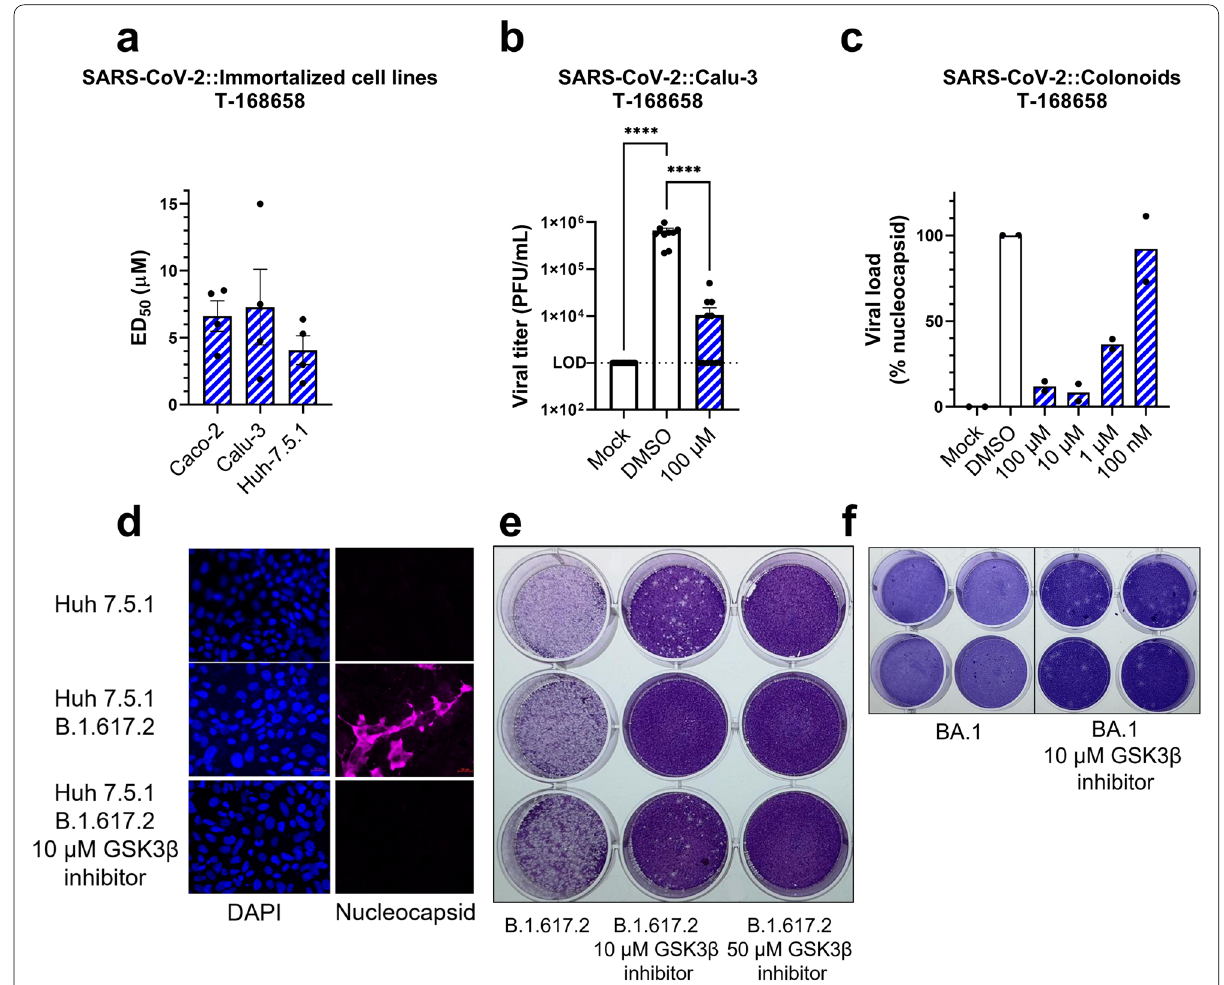
Fig. 3 Characterization of T‑168658 inhibitory activity. a Dose‑response inhibition effect of T‑1686568 in three infected, immortalized cell lines. Data is averaged from four independent experiments; error bars are the SEM. b Viral titer from 48‑h infected Calu‑3 cells, with (100 μM, no host‑cell toxicity observed) and without (DMSO) T‑1686568 from 12 independent infections; error bars are the SEM. One‑way ANOVA with Bonferroni multiple comparison correction, P < 0.0001. LOD – Limit of Detection. c Semi‑dose‑response inhibition effect of T‑1686568 in primary donor‑derived colon organoids, 72 hrs post‑infection. Viral load interpolated to both non‑infected cells (mock) control and an infected, untreated control, quantifying intracellular N protein. GSK3β inhibitor activity against the SARS‑CoV‑2 variants B.1.617.2 (delta) and BA1 (omicron). Immunofluorescence confocal images ( d ) of Huh‑7.5.1 infected with B.1.617.2 with or without 10 μM T‑1686568 treatment for 48 h. Host nuclei (blue), nucleocapsid (magenta), are shown, with scale bar (red) 20 μm. e Plaque assays of B.1.617.2‑infected Vero E6 cells, 2 days post‑infection. f = Plaque assays of BA.1‑infected Vero E6 cells, 2 days